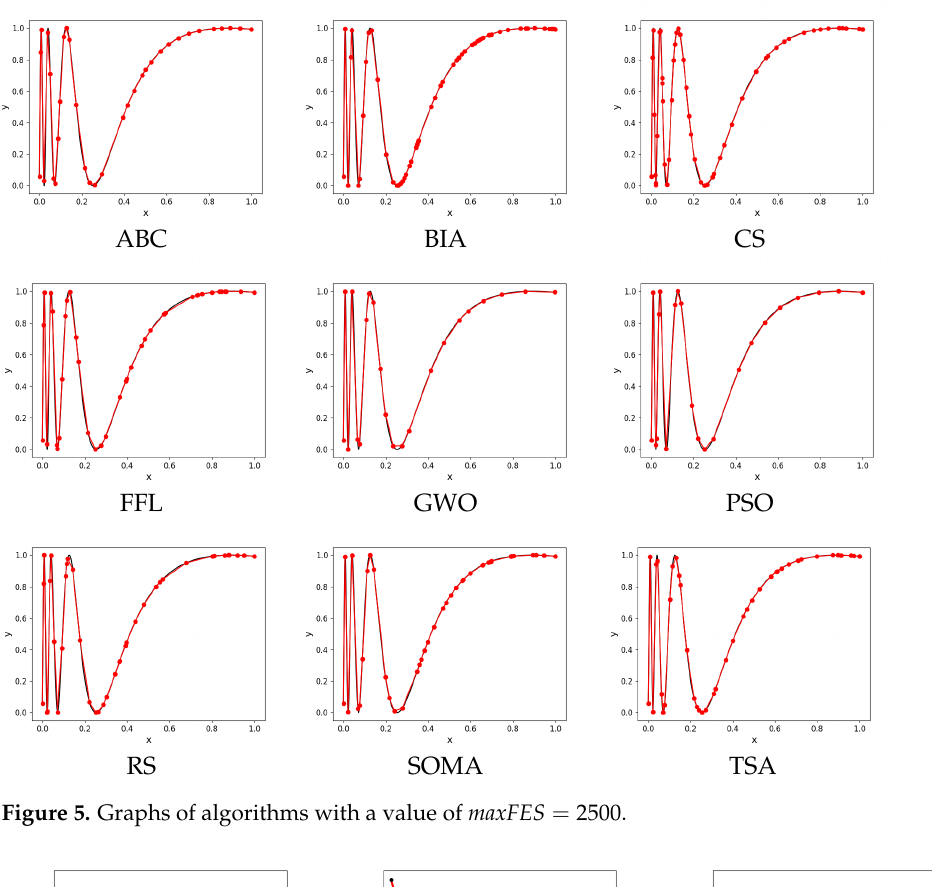
Figure 5. Graphs of algorithms with a value of maxFES = 2500.